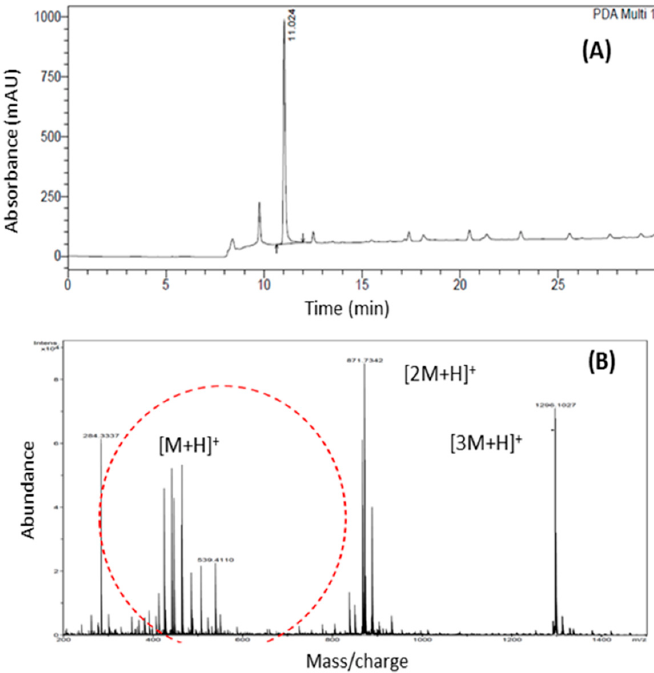
Figure 2. HPLC: ( A ) peak hold of α , β -amyrenone mixture; ( B ) Peak purity index of 0.996605 of α and β -amyrenone.